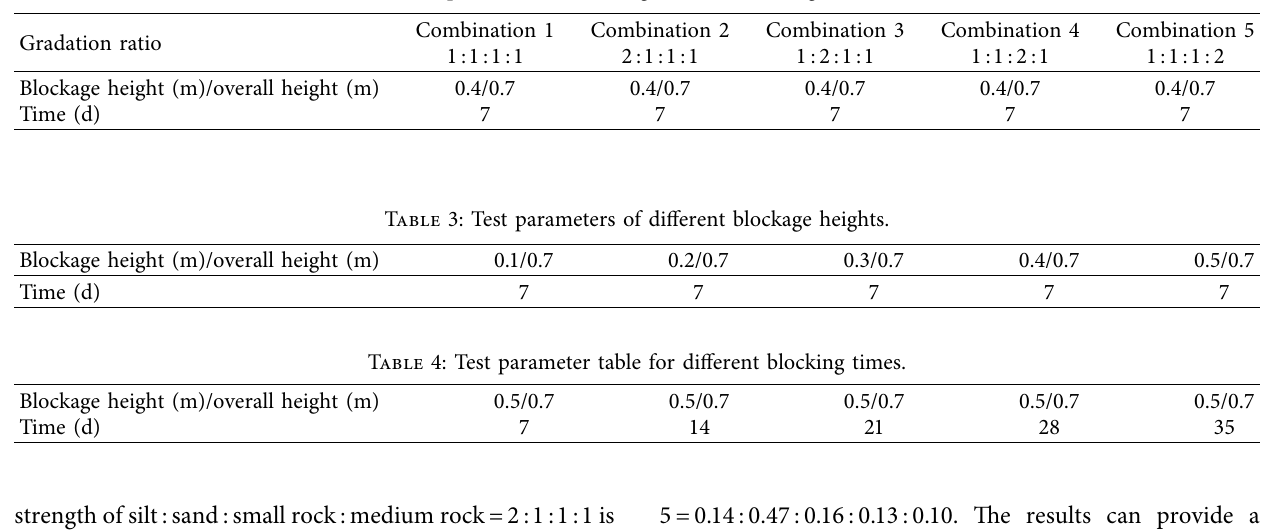
Table 2: Test parameters of blockages with different gradation ratios.